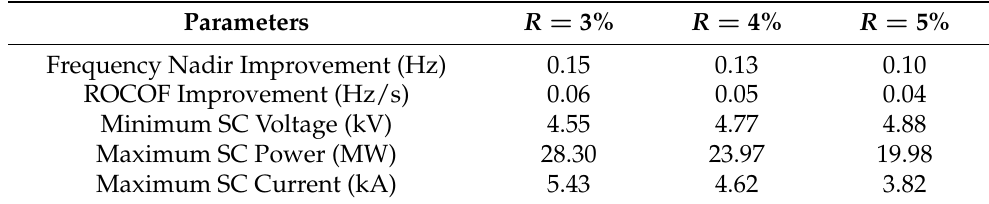
Figure 11. FFR provision from the directly connected SC with varying droop coefficients (from top to bottom: system frequency, SC terminal DC voltage, SC output DC power, SC output DC current). Table 3. Overview of simulation results of FFR provision from the directly-connected SC in systems with varying droop